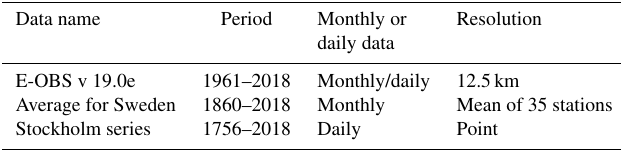
Table 1. Observational data used in the